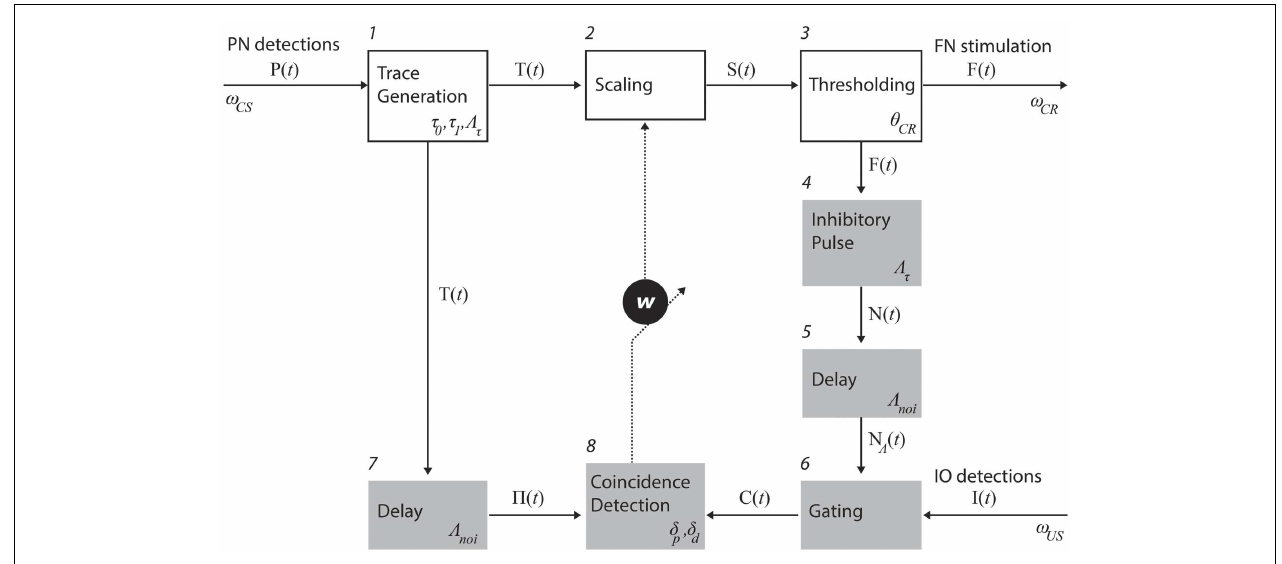
they are involved in the adjustment of w .The numbers identify specific processes.The latencies affecting each of the recording and stimulating channels as well as the parameters used in each process (see main text for an explanation).